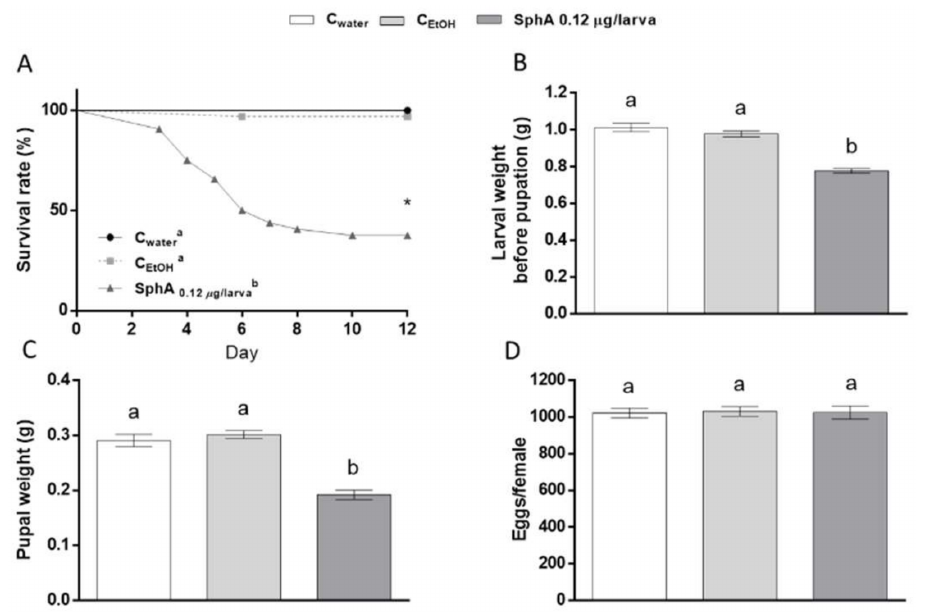
Figure 3. Effect of SphA oral administration 5th instar S. littoralis larvae. Orally treated larvae showed a strong reduction of the survival rate compared to controls, decreasing from day three to pupation. ( A ) (Log-Rank test: χ 2 = 53.66, p < 0.0001, dF = 2). A significant reduction of the larval weight before pupation ( B ) (One Way ANOVA: F (2, 71) = 22.14, p < 0.0001) and of the pupal weight ( C ) (One Way ANOVA: F (2, 71) = 21.41, p < 0.0001) was also observed. No differences were observed in the fecundity of adults obtained from SphA-treated larvae compared with controls ( D ) (One Way ANOVA: F (2, 21) = 0.1408, p = 0.8695 Asterisk indicate significant differences in the survival curves (Log-Rank test, p < 0.0001)). The values in the histograms are means ± SE. Different letters indicate a statistical difference (One Way ANOVA, p < 0.0001).